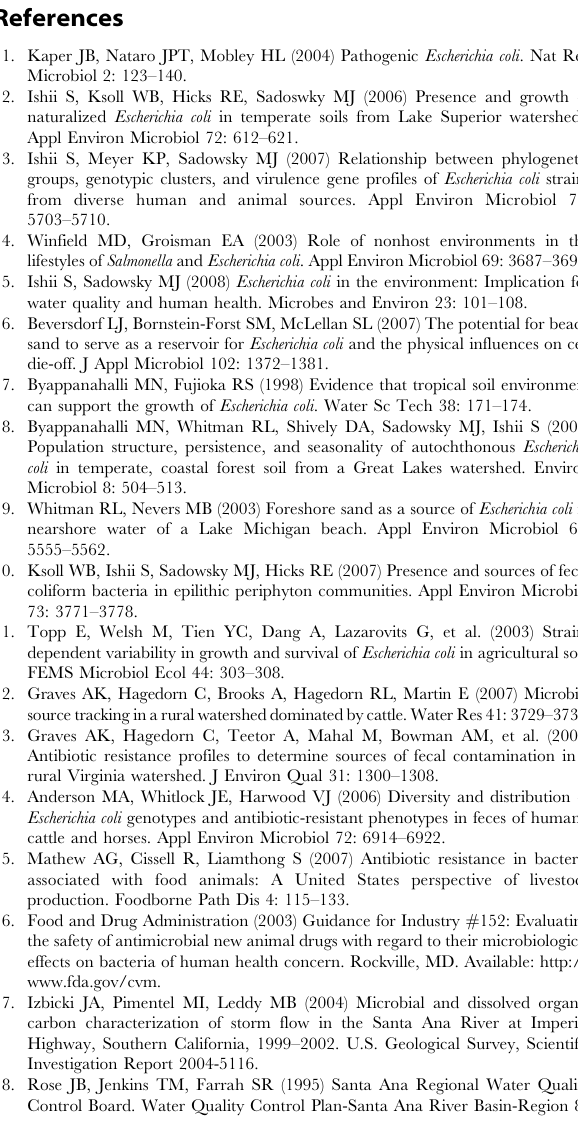
Figure S1 The pattern of diversity of E. coli isolates in the MSAR watershed: (a) soil from Chino creek, (b) water from Chino Creek, (c) water from Cypress channel, (d) water from WWTPs, (e) soil from Prado, and (f) water from the Prado park area. Sample names on the X axis are as shown in Figure 1 and Table 1 followed by dates that samples were collected from the different sites. Figure S2 Multiply antimicrobial resistant E. coli isolates. The bars in Figure 5a as an example shows;